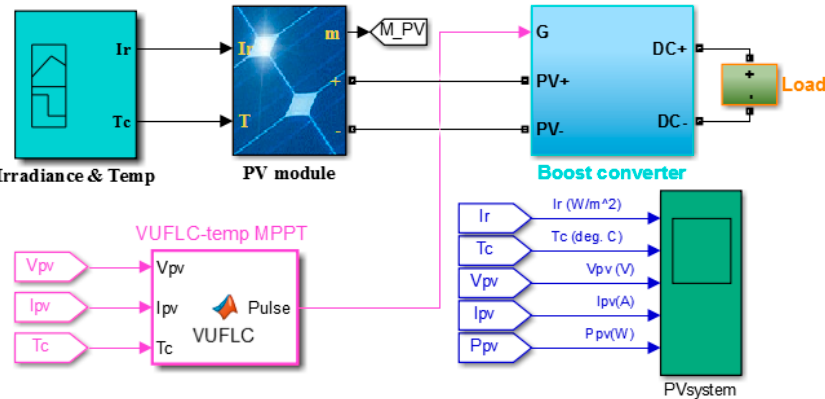
Figure 9. Simulation model of the VUFLC-temperature PV MPPT system.